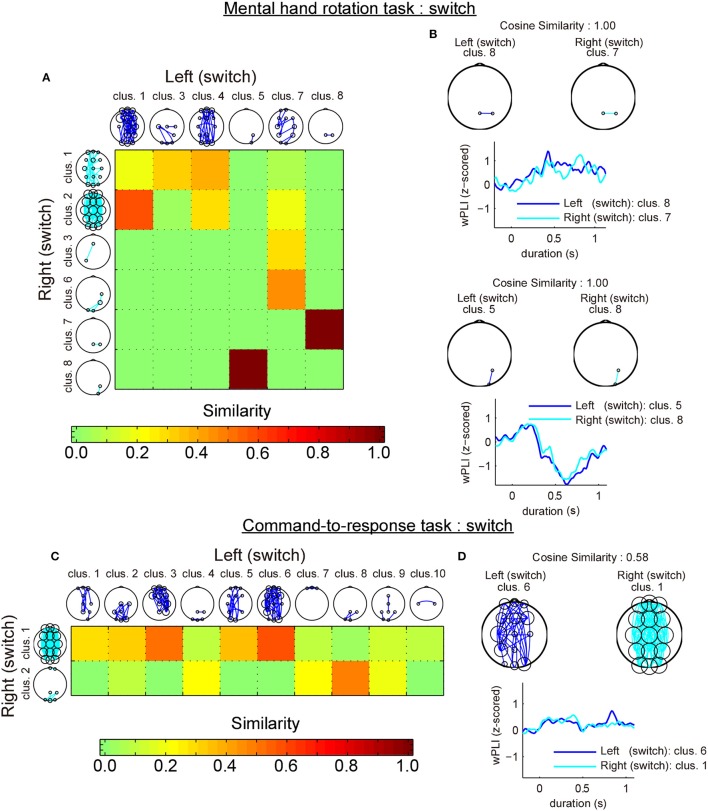
Comparison of the cluster-by-cluster similarity of the connectivity patterns (switch trials). (A) A matrix indicating the cluster-by-cluster similarity between left and right hand in the mental hand rotation task for the switch trials. (B) Pairs of most similar clusters between the two laterality conditions in the mental hand rotation task for switch trials and comparison of the temporal responses. (C,D) These also show the results of the cluster-by-cluster similarity analysis of the connectivity patterns in the command-to-response task for the switch trials.